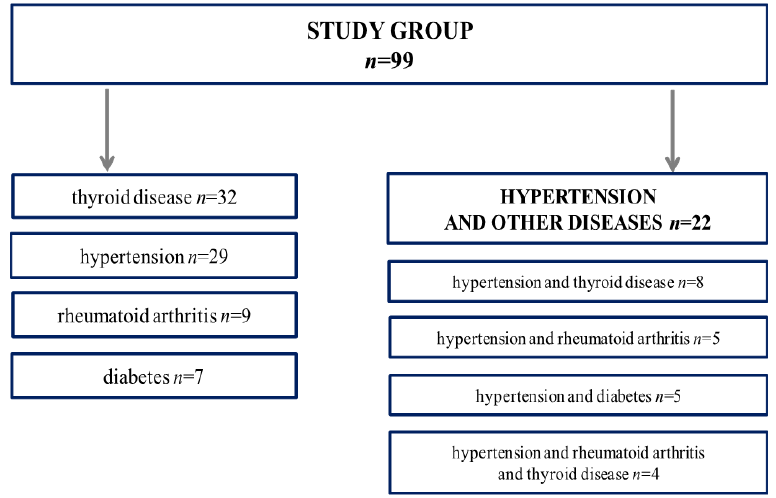
Figure 1. Schematic illustration of the participants’ selection according to age-related diseases.